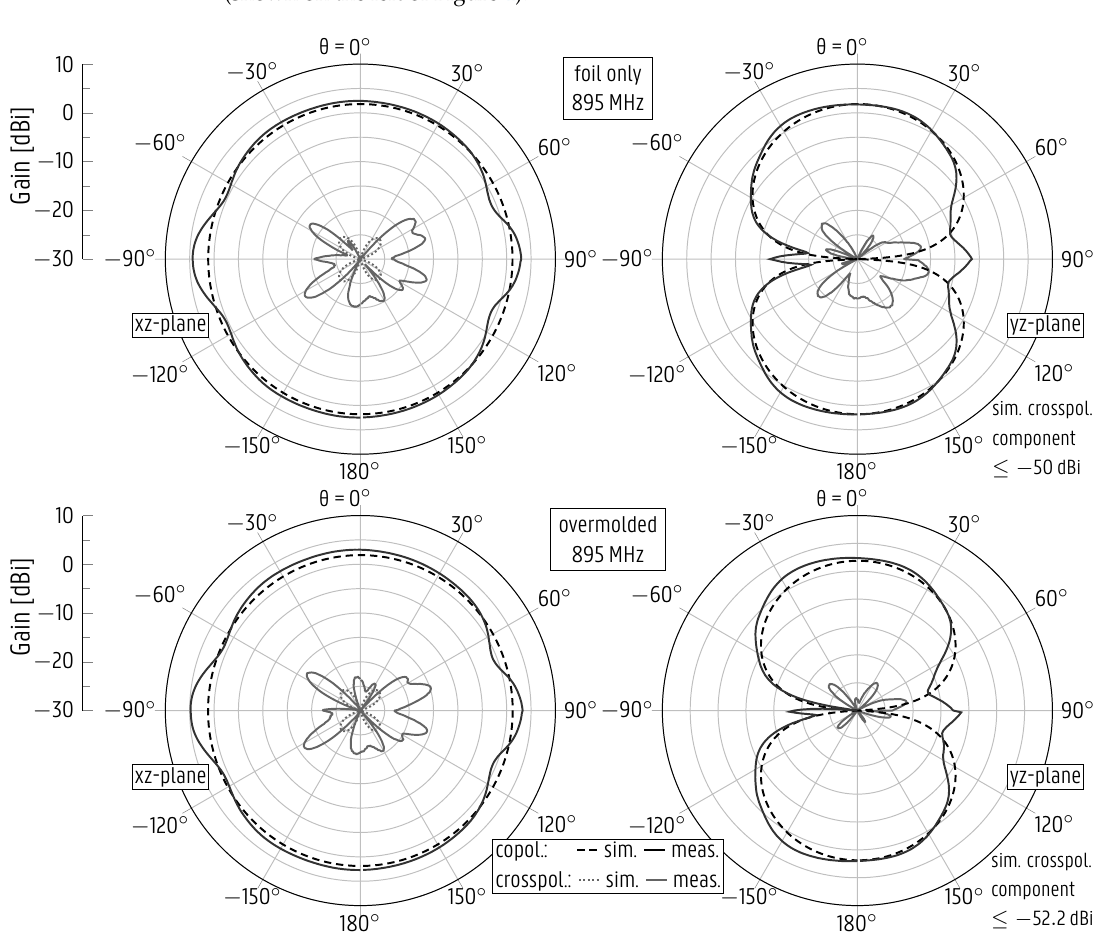
Figure 7. Simulated and measured radiation patterns of the monopole antenna stand-alone printed on plastic foil ( top ) and after overmolding ( bottom